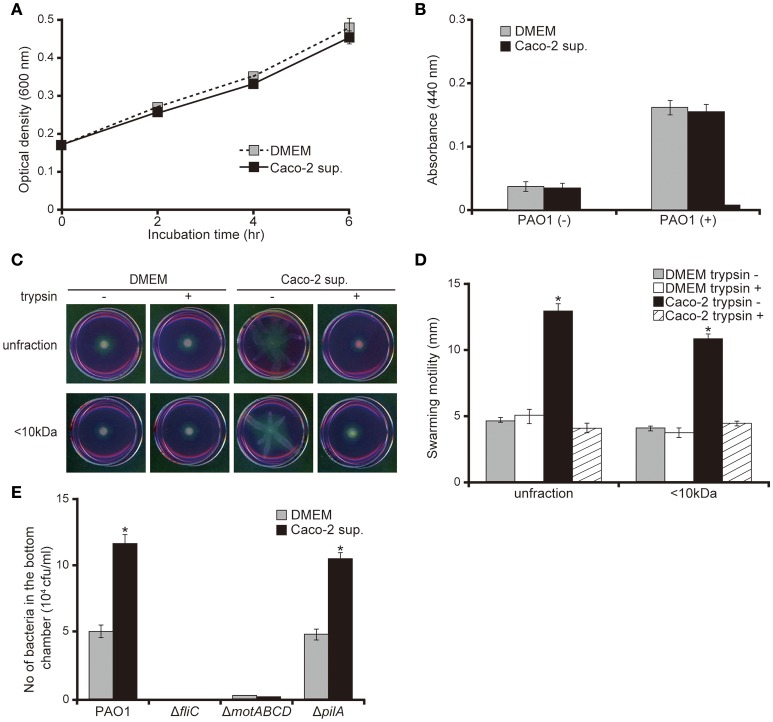
Caco-2 cell supernatant facilitates a swarming motility of the P. aeruginosa PAO1 strain. (A) The P. aeruginosa PAO1 strain was incubated in Caco-2 cell supernatant (Caco-2 sup.) or Dulbecco's modified Eagle medium (DMEM; control) at 37°C in 5% CO2. After incubation, the optical density (600 nm) of the culture was measured at the indicated times. Error bars indicate standard error (n = 3). (B) After incubation of the P. aeruginosa PAO1 strain in Caco-2 cell supernatant (Caco-2 sup.) or DMEM (control) at 37°C in 5% CO2 for 5 h, the azocasein degradation activity of the collected culture supernatant was measured. Error bars indicate standard error (n = 3). (C) A 15-day Caco-2 cell supernatant (Caco-2 sup.) and DMEM (control) were filtered through 10-kDa MW cut-off membranes. The <10 kDa fraction and unfiltered samples were treated with or without trypsin (trypsin + or −). The P. aeruginosa PAO1 strain was spotted on swarming agar containing the treated samples. After incubation for 14 h, the swarming agar plates were observed and photographed. (D) The radial distance (mm) from the center of the agar was measured. Error bars indicate standard error (n = 3). *P < 0.05 compared with DMEM at the same size fraction. (E) A 15-day Caco-2 cell supernatant (Caco-2 sup.) or DMEM (control) was filled in the bottom chamber of Transwell. The P. aeruginosa PAO1 strain, flagellar mutants (ΔfliC and ΔmotABCD), or a type IV pilus mutant (ΔpilA) were added to the top chambers, and after 3 h, the numbers of bacteria in the bottom chambers were counted. Error bars indicate standard error (n = 3). *P < 0.05 compared with incubation in DMEM of the same strains.